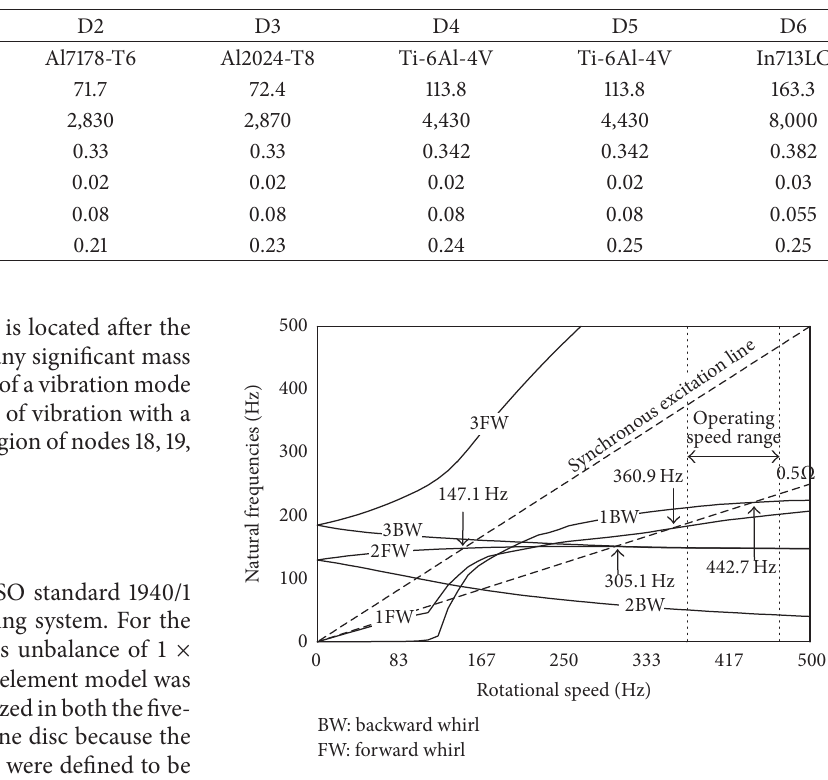
Table 3: Physical and geometric properties of the discs.